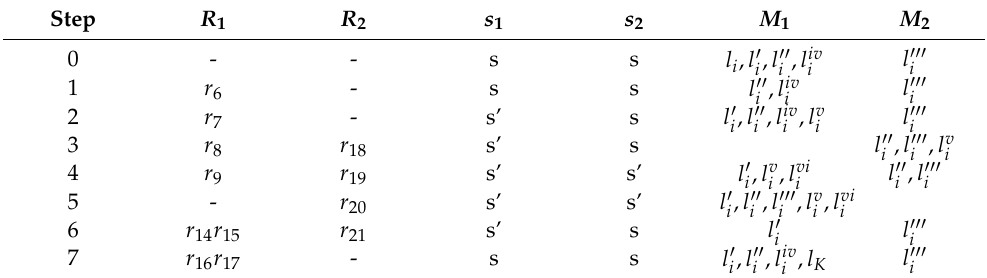
Table 2. The application of rules in R 1 and R 2 , the evolution of channel states s 1 and s 2 , and the rewriting of multisets M 1 and M 2 in membrane 1 and 2, respectively. During the simulation of a SUB